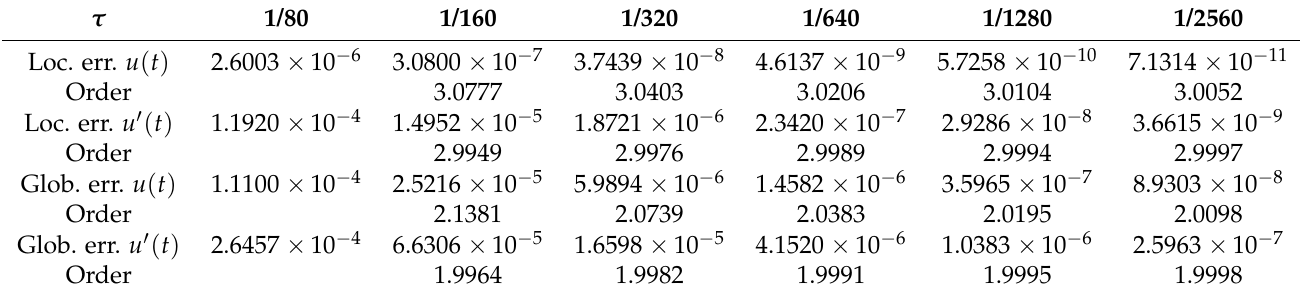
Table 4. Local and global errors and orders for problem (15) with RN2.